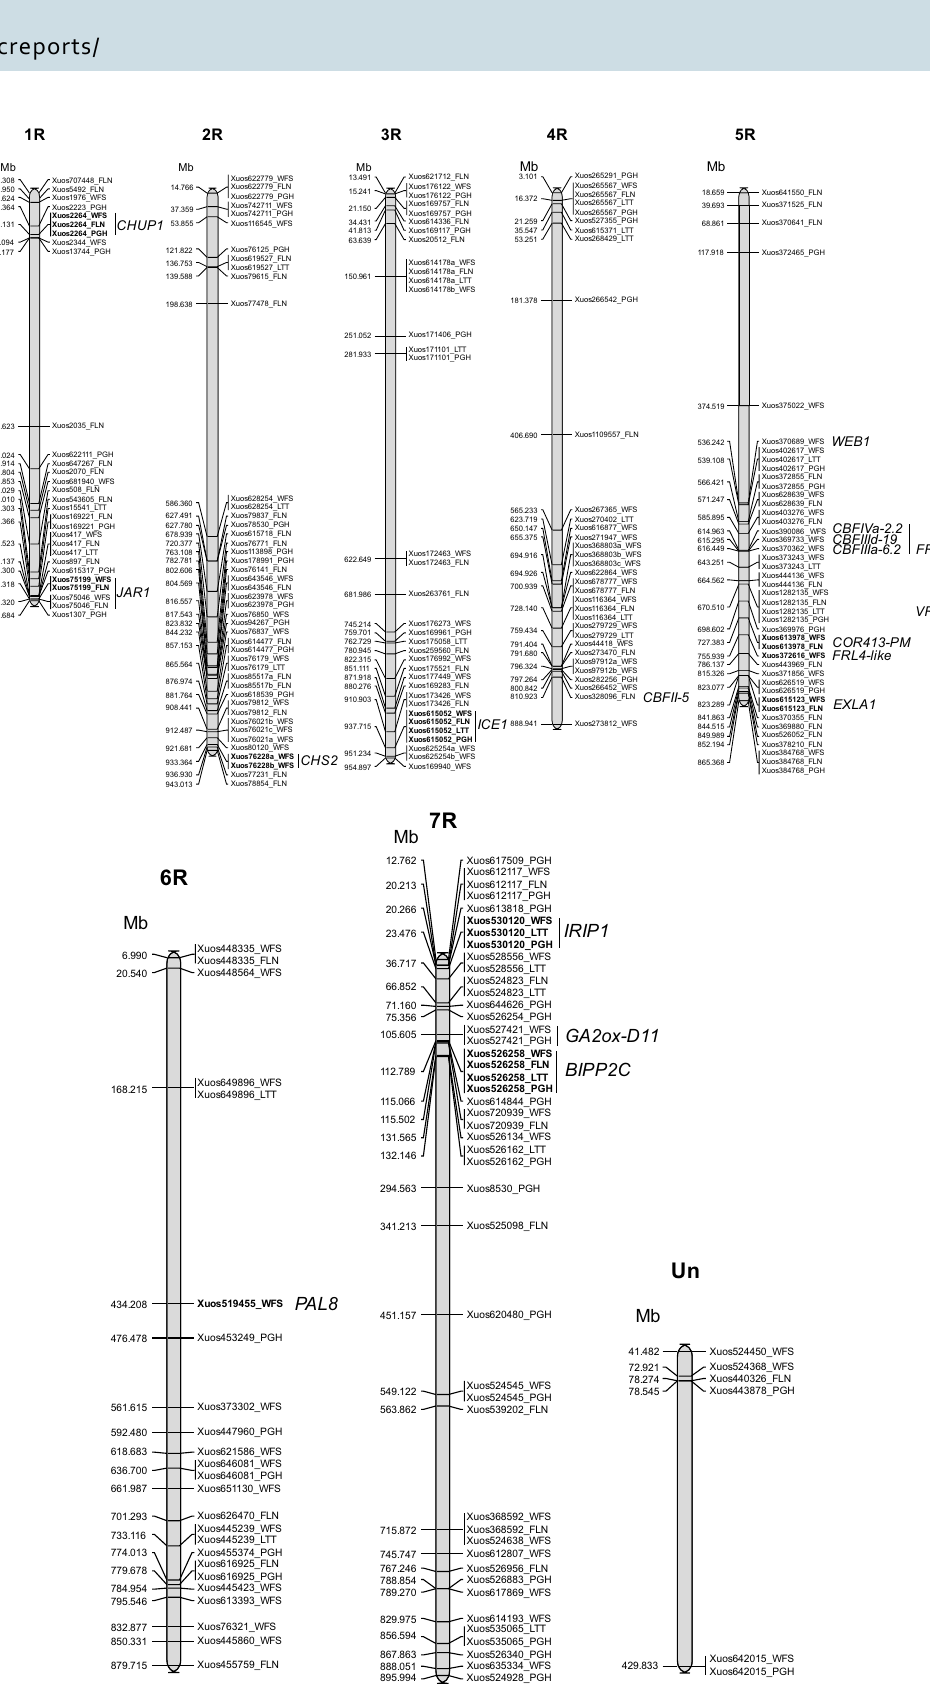
Figure 4. Location of significant MTAs identified on rye physical map. Locations refers to the Lo7 v1 pseudomolecules 2021 4 . Most significant markers ( p < 1.49e−04; Table 2) are indicated in bold. Location of FR- R2 , VRN1 , and discussed candidate genes are